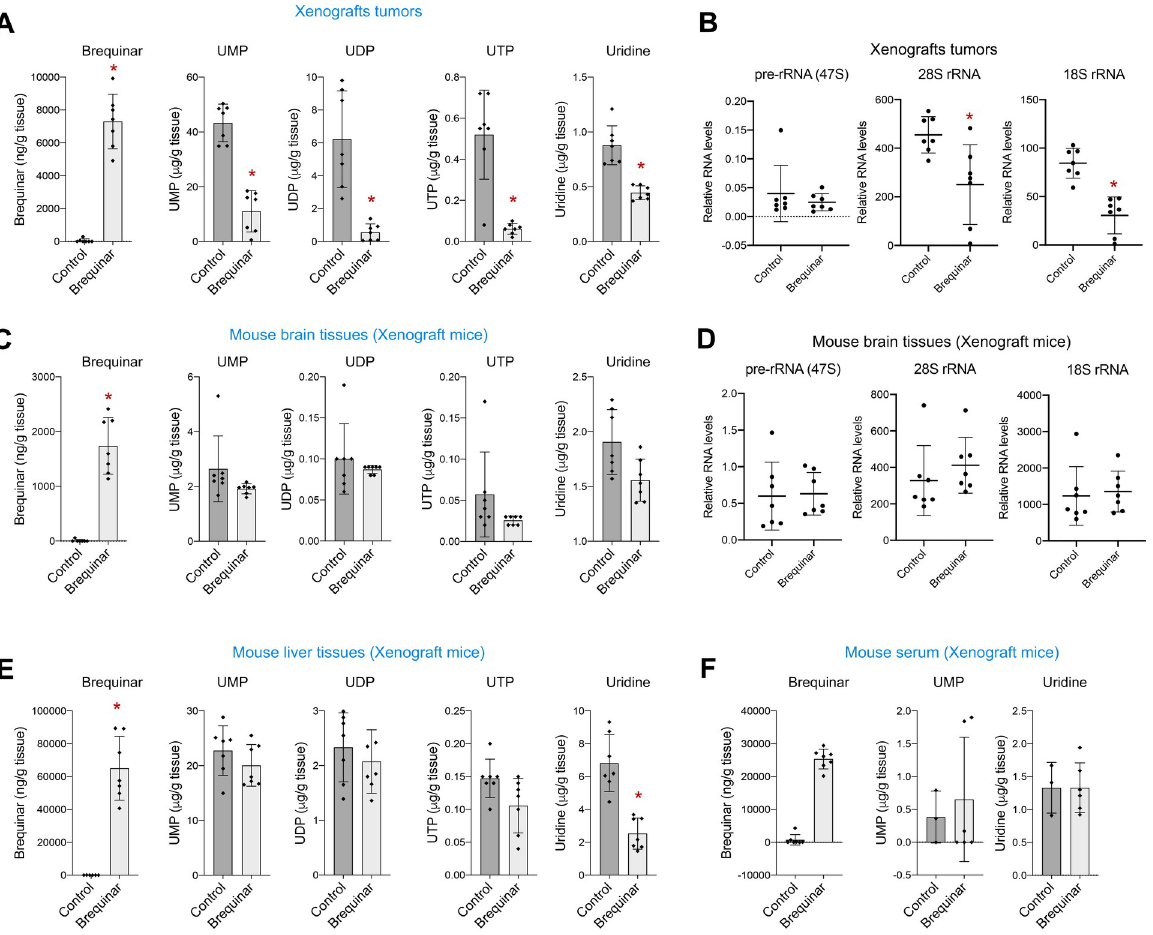
Fig 4. Blocking DHODH with brequinar reduces the production of ribosomal RNA in glioblastoma tumors xenograft in vivo . (A) Amounts of brequinar, UMP, UDP, UTP and uridine in the LN229 xenografts measured by LC-MS/MS. (B) qPCR of 47S pre-rRNA and 28S and 18S rRNAs in the LN229 xenografts. 47S pre-rRNA, 28S and 18S levels were normalized by ACTIN mRNA levels. (C) Amounts of brequinar, UMP, UDP, UTP and uridine measured by LC-MS/MS in the brain tissues of mice used for xenografts. (D) qPCR of 47S pre-rRNA and 28S and 18S rRNAs in the brain tissues of the mice used for LN229 xenografts. 47S pre-rRNA, 28S and 18S levels were normalized by ACTIN mRNA levels. (E) Amounts of brequinar, UMP, UDP, UTP and uridine measured by LC-MS/MS in the liver tissues of mice used for xenografts. (F) Amounts of brequinar, UMP, and uridine measured by LC-MS/MS in the serum of mice used for xenografts. Last brequinar injection was 3 h before harvesting the tissues. Numerical values for each of the experiments represented are available in S4 Data.